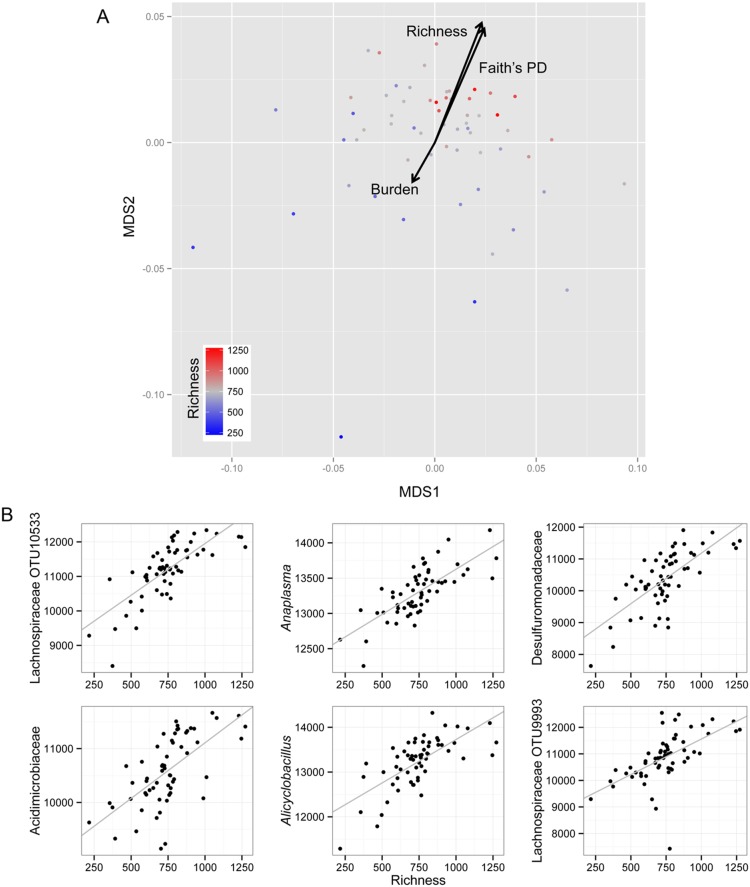
Variation in lower airway bacterial community composition is related to micobiological variables.
A. NMDS ordination illustrating dis-similarity in bacterial community composition of 60 Ugandan HIV-infected patients with acute pneumonia. Degree of community richness (number of taxa detected in each sample) is indicated by color gradient. The ordination is overlaid with biplots to exhibit the observed relationships between bacterial community composition and bacterial richness, Faith’s phylogenetic diversity (PD) and bacterial burden. B. Top six taxa exhibiting the strongest significant positive correlations with microbial community richness (p<0.05; q<0.05).